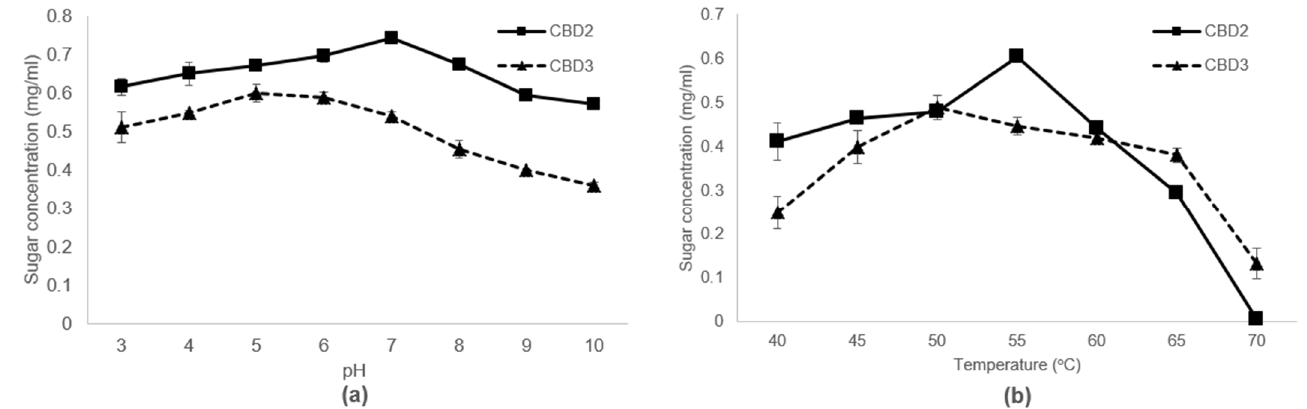
Figure 4. Optimal working conditions, ( a ) pH and ( b ) temperature, of bacterial cellulases produced from CBD2 and CBD3. Table 4. CMCase activities and specific enzyme activities at the optimal working condition of crude cellulases produced from CBD2 and CBD3 and commercial Celluclast 1.5 L. Enzyme Activity Specific Enzyme Activity Enzyme Optimal Condition (U/mL)